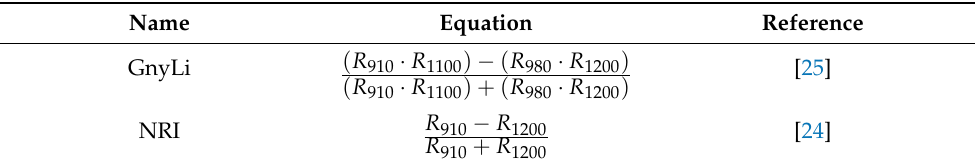
Table 2. NIR/SWIR vegetation indices derived from the camera system and used in this study. The wavebands used differ from the original selection of Gnyp et al. [25] and Koppe et al. [24], partly due to the limited range of readily available narrow-band and high-performance bandpass filters for this